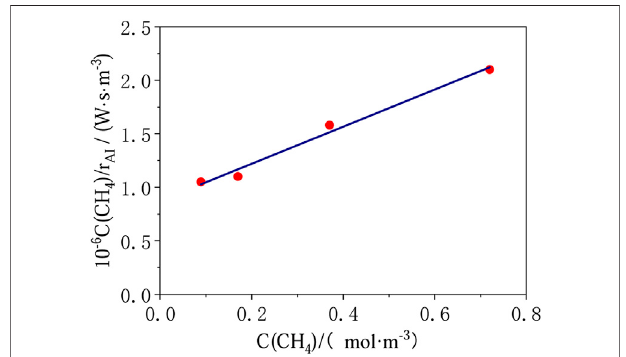
FIGURE 3 | Results of photocatalytic total oxidation of methane for oxygen rich mixtures (T (cid:1) 313 K, p (cid:1) 1 bar, I (cid:1) 14.5 W/m 2 , C(O 2 ) (cid:1) 6.81 mol/m 3 ).